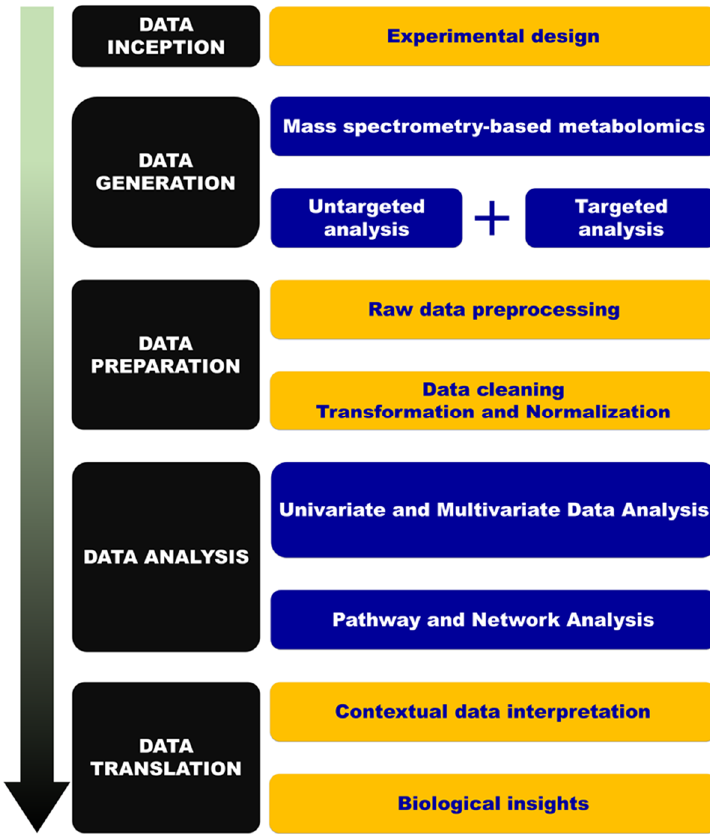
Figure 4. Illustration of the metabolomics workflow spanning from experimental design to pathway analysis and biological interpretation. HMDB: Human Metabolome Database. KEGG: Kyoto Encyclopedia of Genes and Genomes. MetCCS: Metabolite CCS database. MSEA: Metabolite Set Enrichment Analysis. RSD: relative standard deviation.